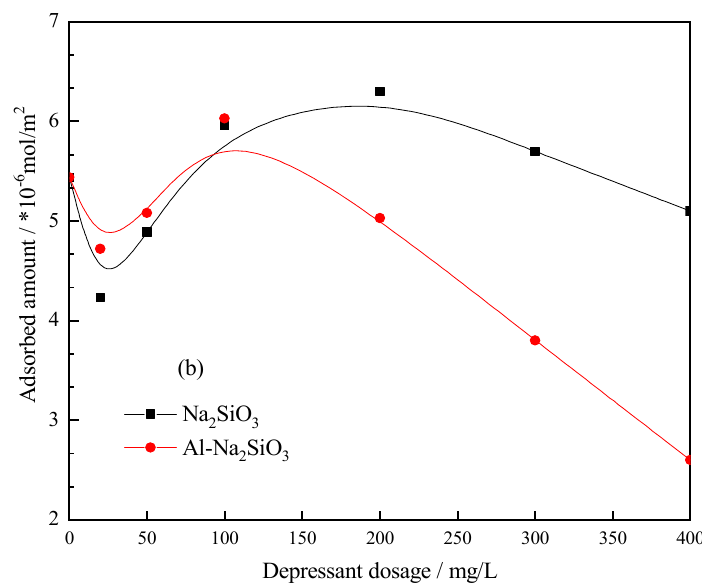
Figure 13. Pb-BHA amount adsorbed on the ( a ) scheelite and ( b ) calcite surface at different concentrations of Na 2 SiO 3 and Al-Na 2 SiO 3 polymer (pH = 8.0 ± 0.1, C Pb = 3 × 10 − 4 mol/L, C BHA = 1.5 × 10 − 4 mol/L).